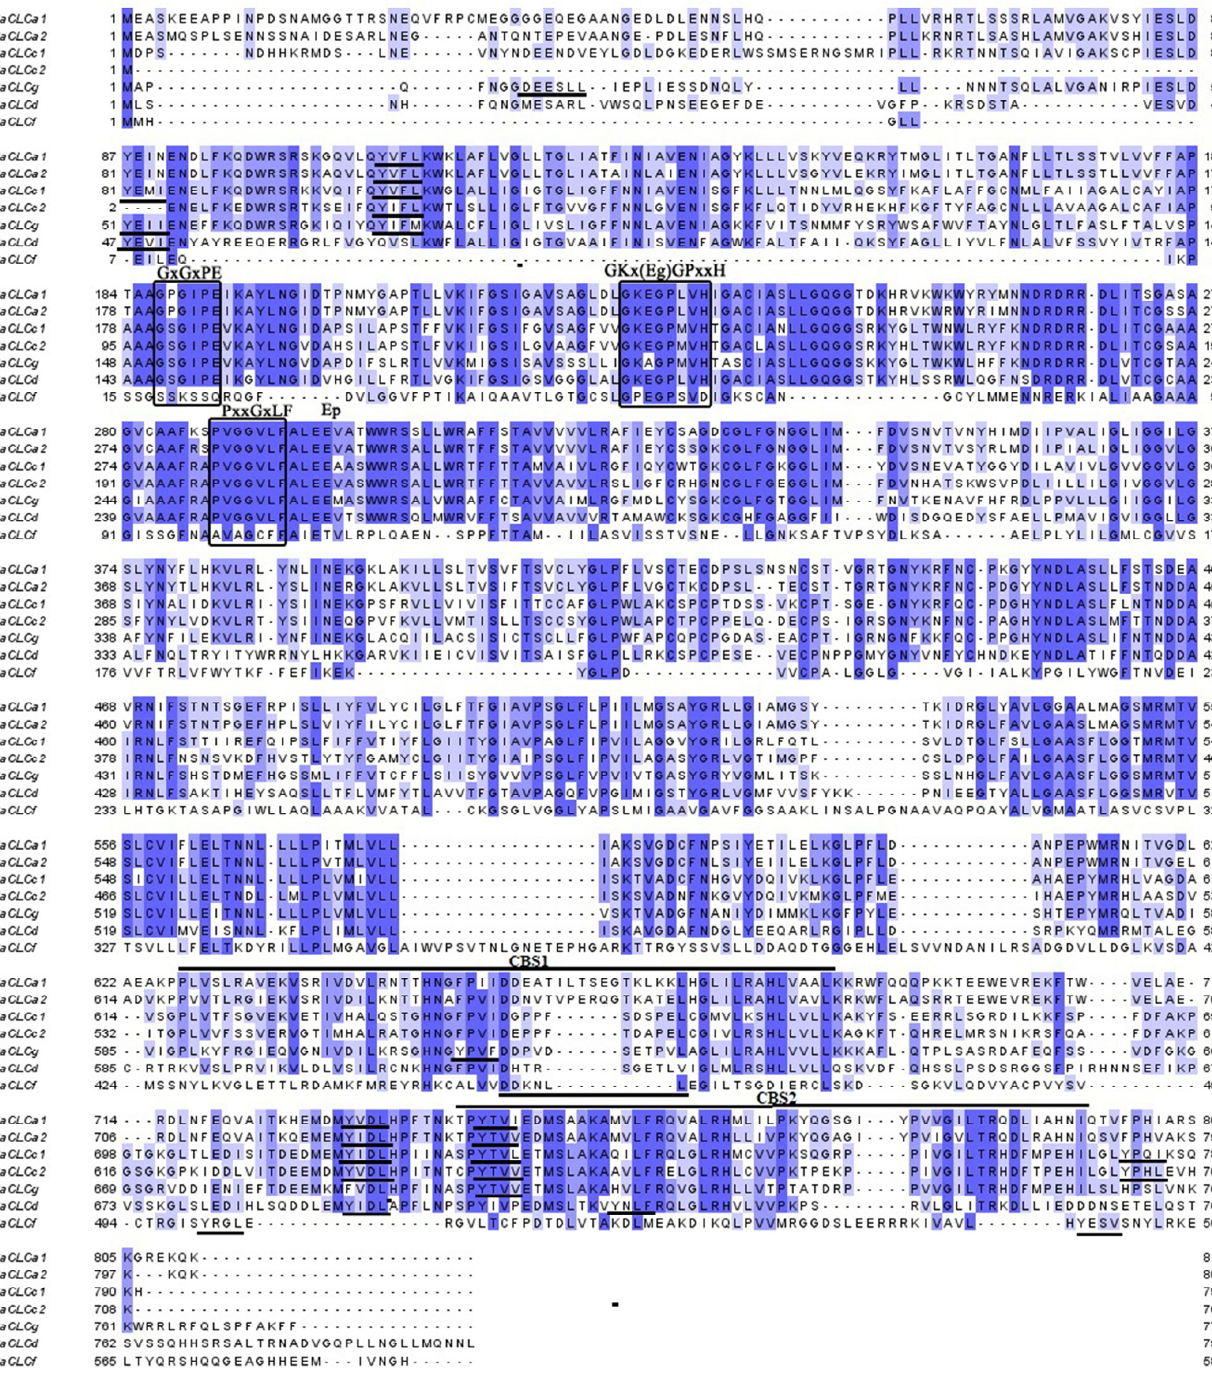
Figure 1. Alignment of the amino acid sequences of CLC proteins from Suaeda altissima : SaCLCa1 (GenBank, acc. no. ANG09048.1), SaCLCa2 (GenBank, acc. no. OM994378), SaCLCc1 (GenBank, acc. no. AVQ93350.1), SaCLCc2 (GenBank, acc. no. OM994379), SaCLCd (GenBank, acc. no. OK626332), SaCLCf (GenBank, acc. no. OK626333), and SaCLCg (GenBank, acc. no. OK626334). The alignment was performed in the MAFFT program and visualized in Jalview 2.11.1.4 program. The conserved amino acid motifs (GxGxPE, GKxGPxxH and PxxGxLF) are framed. GxGxPE motif is a selective filter. Eg and Ep are the key glutamates of the CLC family proteins. The intensity of staining for amino acid residues depicts the degree of their identity (identity percentage). Putative sorting signals YXX Φ (where Φ is a bulky hydrophobic residue) and [D/E]XXXL[L/I], CBS1 and CBS2 domains are